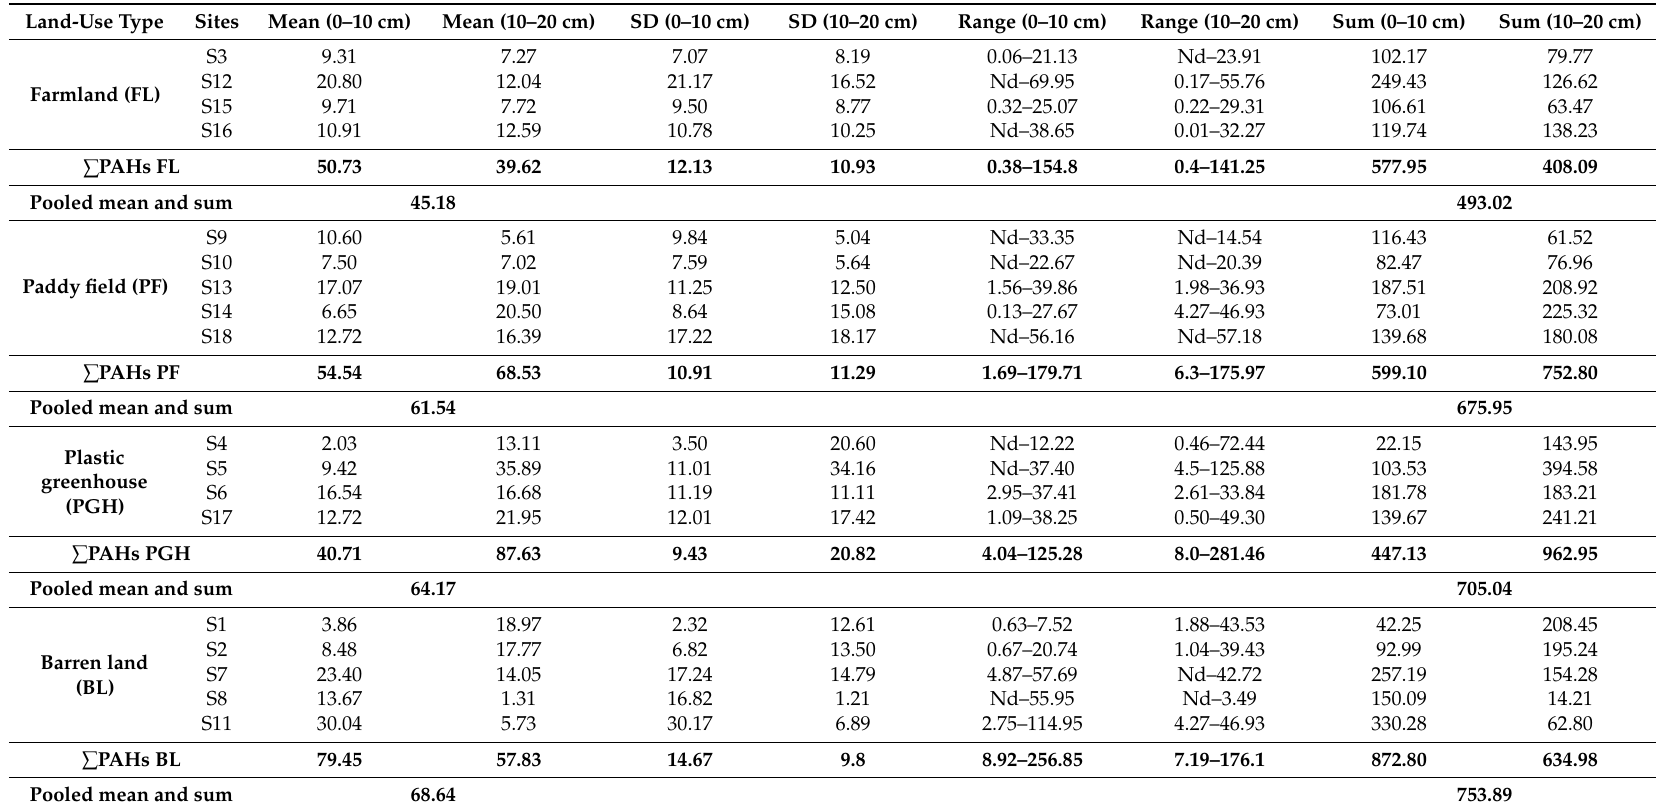
Table 3. Spatial distribution and concentration of PAHs in different land-use